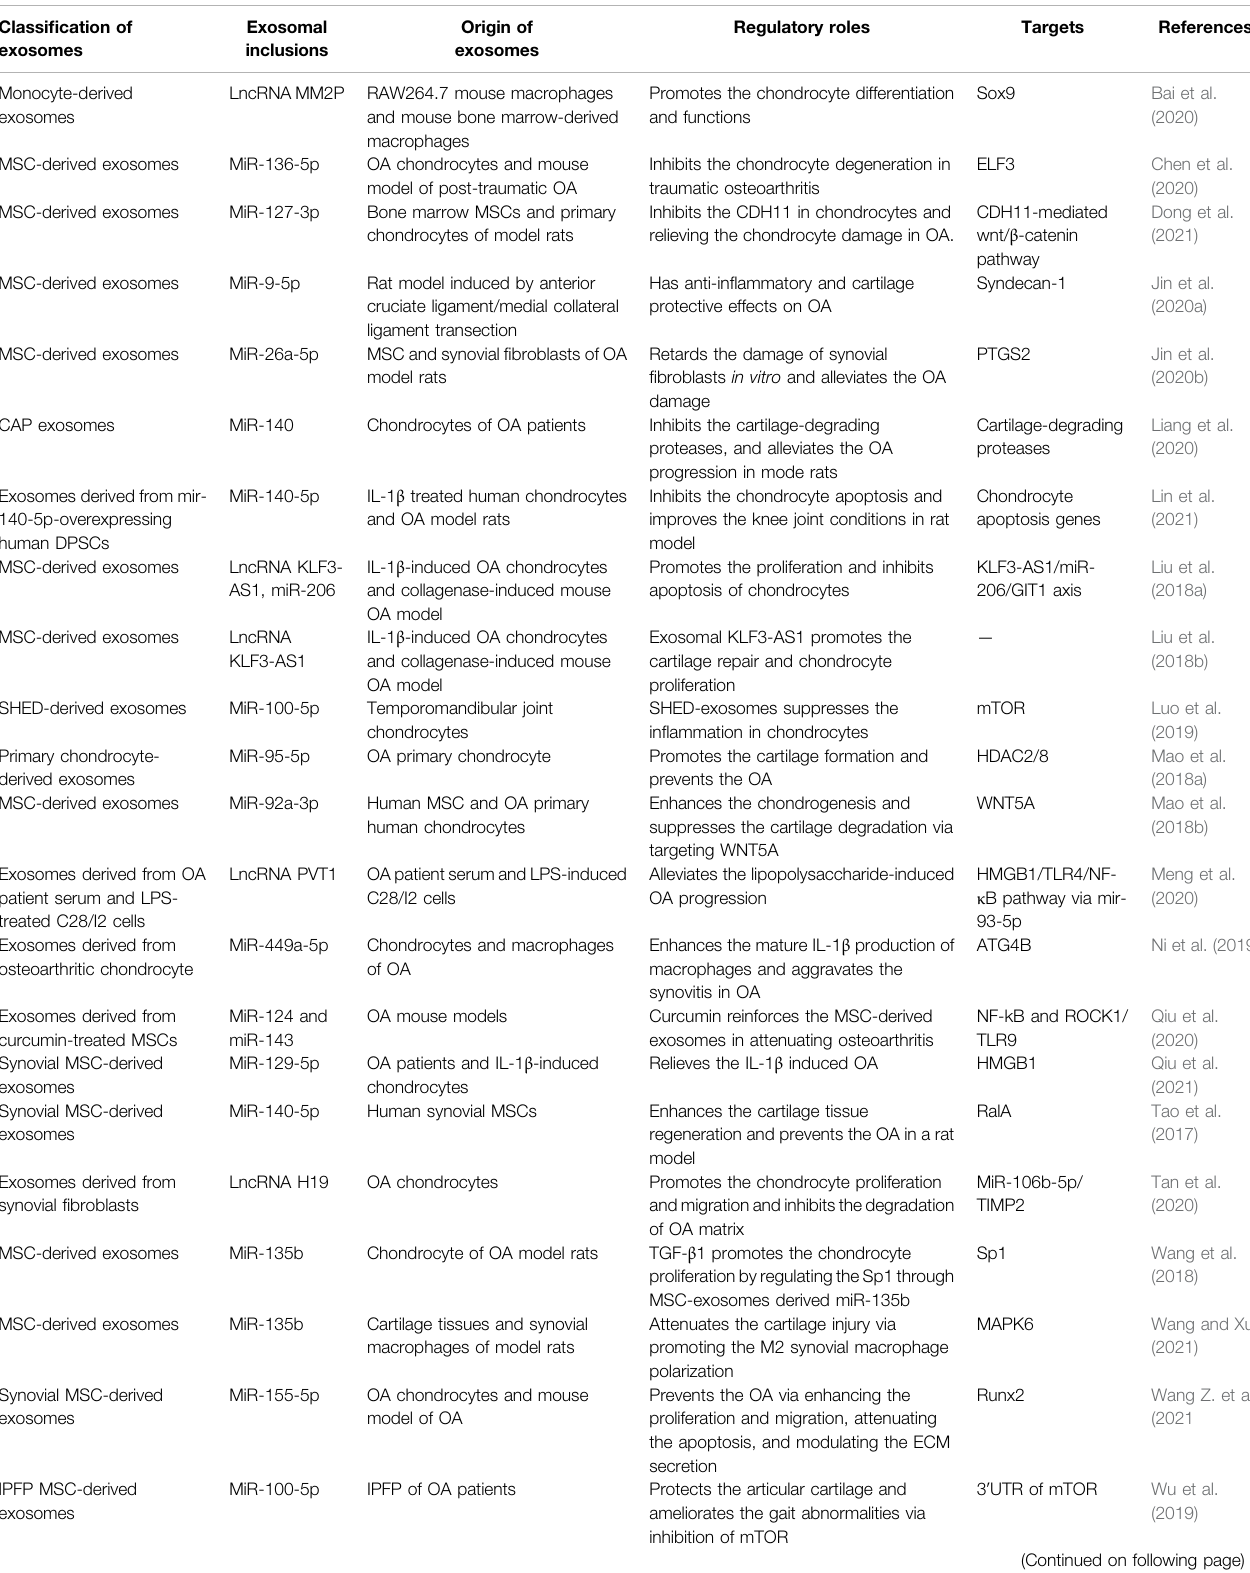
TABLE 1 | Exosomes reported in the pathogenesis of